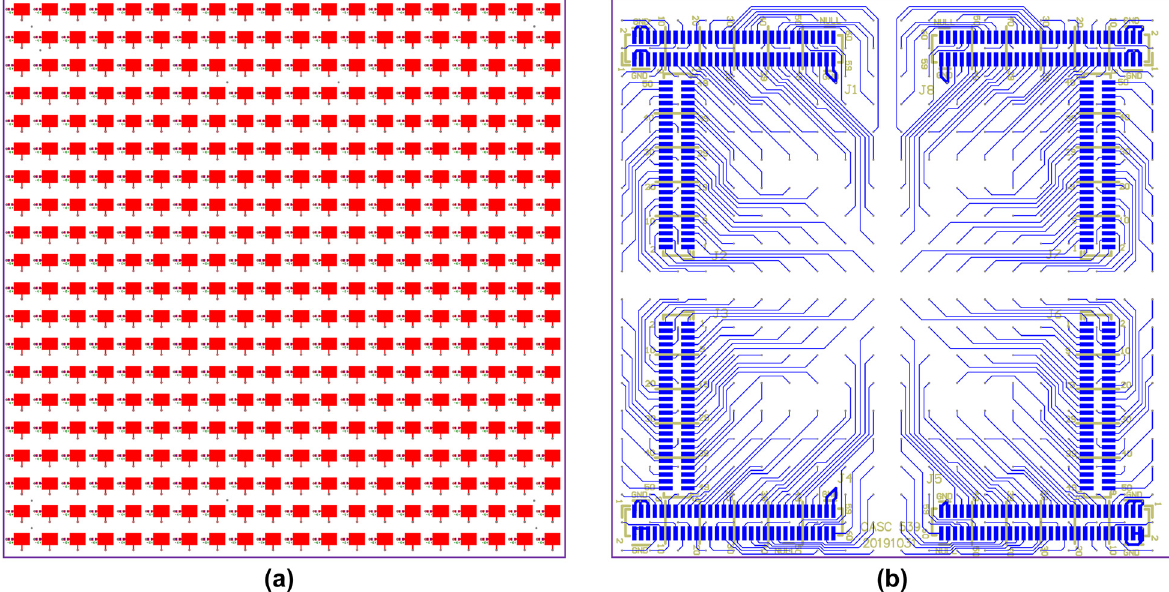
Figure 4: Overall configuration of the proposed metasurface with 20 × 20 units. (a) Top layer with the reflective patches. (b) Bottom layer with bias layer network